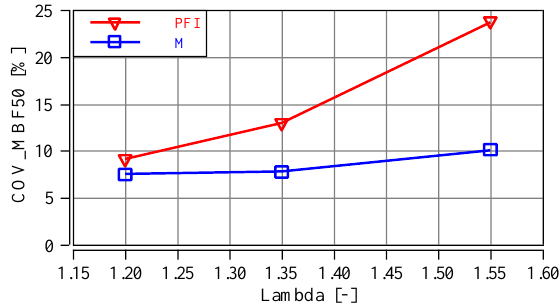
Fig. 10. Effects of injection system on coefficient of variation of 50% mass burned friction (MBF50%) for different charge composition